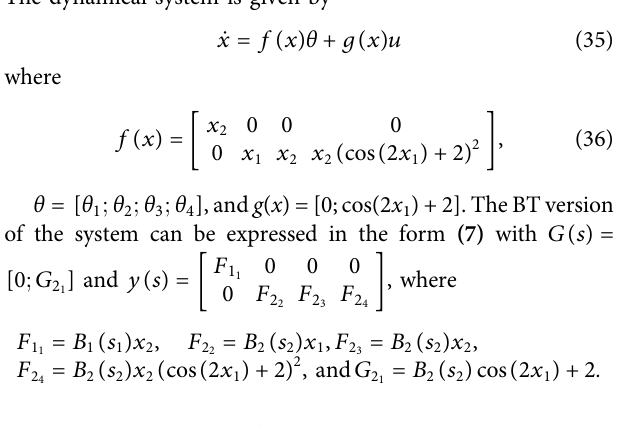
2 The source code for these simulations is available at https://github.com/scc-lab/